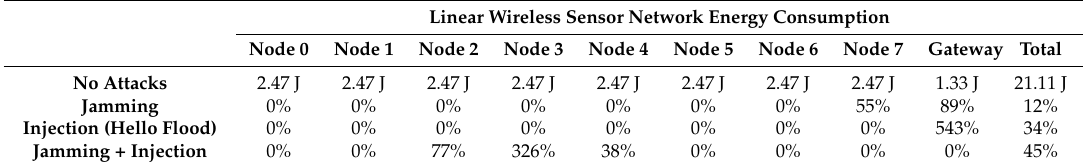
Table 3. Energy consumption estimations for Linear Network.